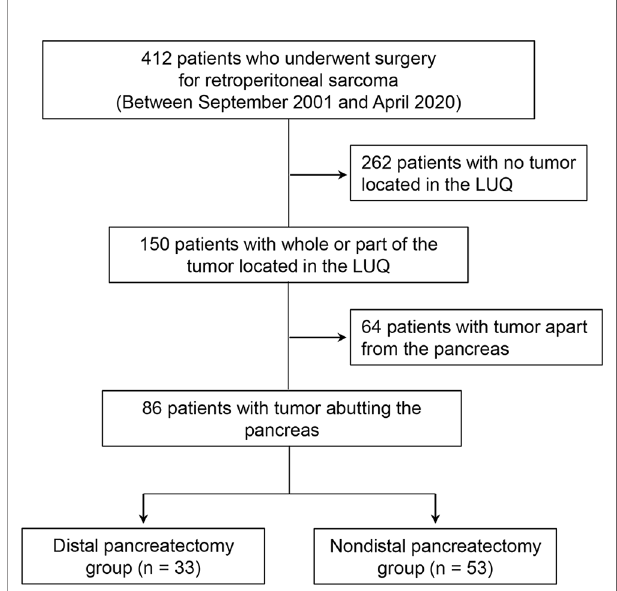
FIGURE 1 | Flow diagram of patient selection criteria for our study. LUQ, left upper